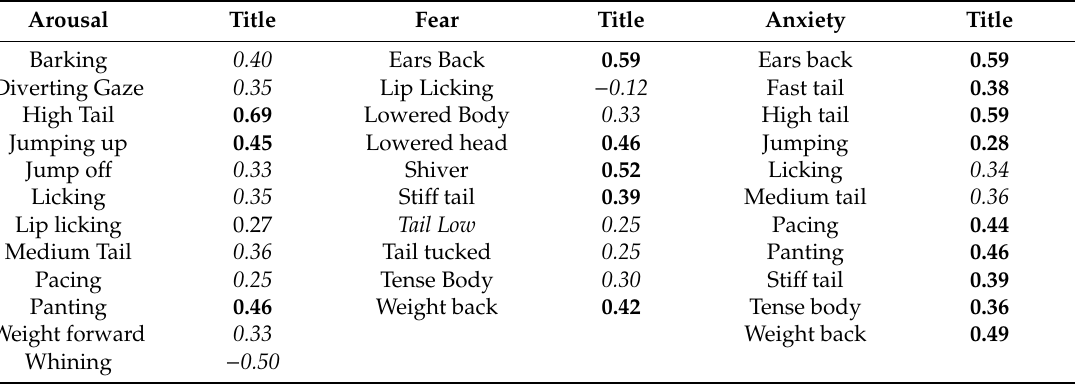
Table 8. Spearman Rank correlation coe ffi cients between behaviours recorded in kennel and behaviours exhibited during the ‘exploration of room test’ in the behaviour assessment of shelter dogs ( n = 38) within the emotional domains of arousal, fear, and anxiety.